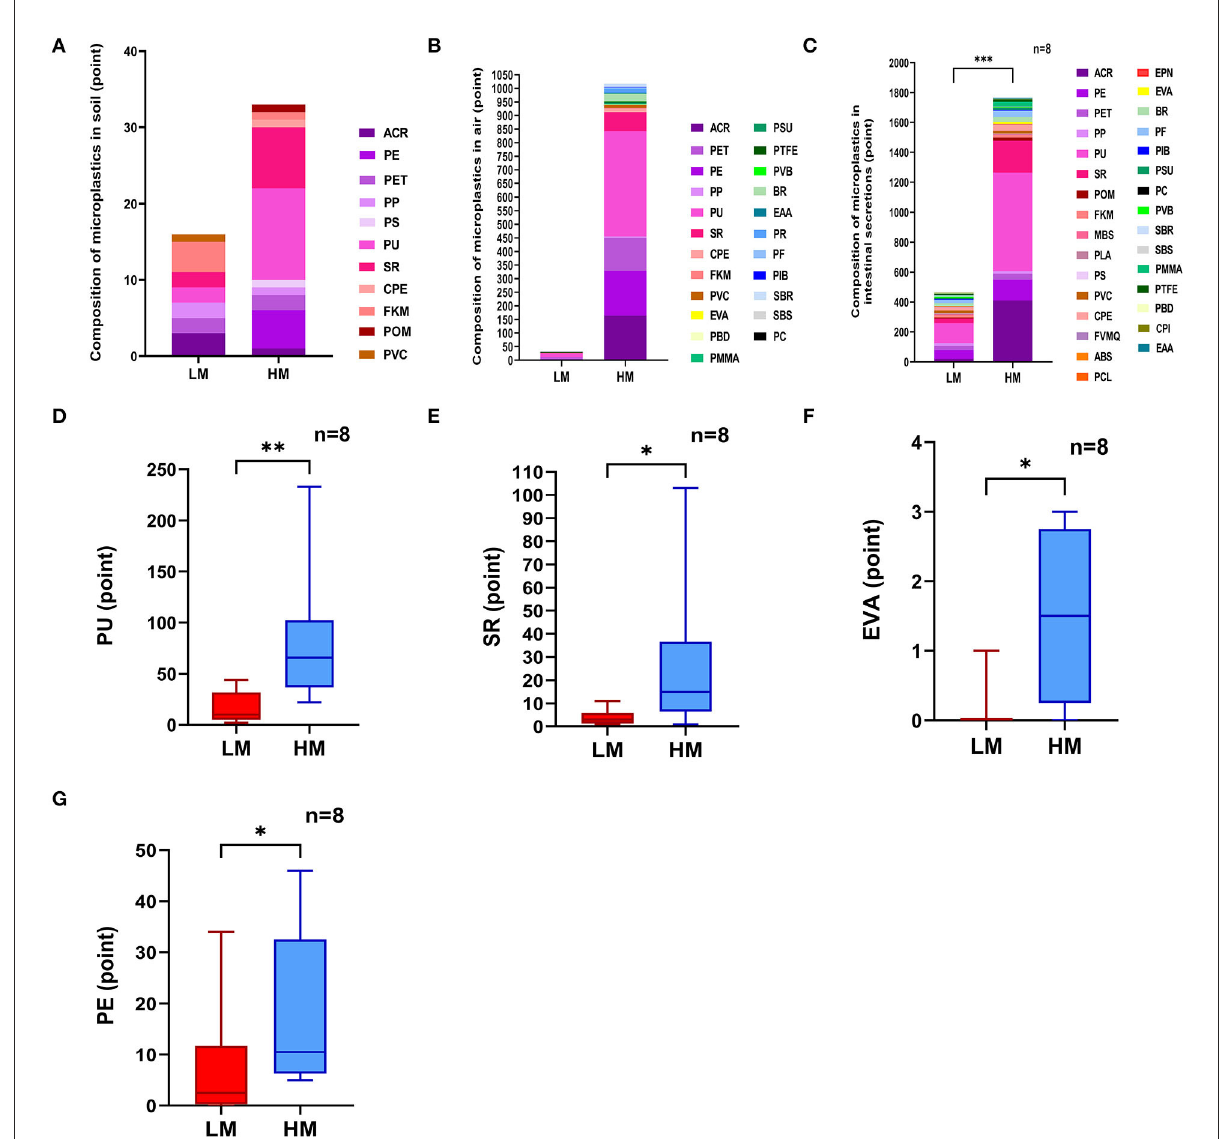
FIGURE1 Analysis of microplastics. (A) Analysis of microplastics from soil. (B) Analysis of microplastics from air particles. (C–G) Analysis of microplastics from intestinal secretions. Acrylic resin, ACR; Polyethylene, PE; Polyethylene terephthalate, PET; Polypropylene, PP; Polystyrene, PS; Polyurethane, PU; Silicon resin, SR; Chlorinated polyethylene, CPE; Fluoro rubber, FKM; Polyoxymethylene, POM; Polyvinylchloride, PVC; Ethylene-vinyl acetate, EVA; Polybutadiene, PBD; Polymethyl methacrylate, PMMA; Polysulfone, PSU; Polytetrafluoroethylene, PTFE; Polyvinyl Butyral, PVB; Butadiene rubber, BR; Ethylene-acrylic acid copolymer, EAA; Petroleum resin, PR; Phenolic resin, PF; Polyisobutylene, PIB; Properties, SBR; Styrene-butadiene-styrene copolymer, SBS; Polycarbonate, PC; Polyoxymethylene, POM; Methylmethacrylate-butadiene-styrene, MBS; Polylactic acid, PLA; Fluorosilicone rubber, FVMQ; Acrylonitrile-butadiene-styrene, ABS; Polycaprolactone, PCL; Novolac epoxy resin, EPN; Polysulfone, PSU; Polybutadiene, PBD; Chlorinated Polyisoprene, CPI; Ethylene-acrylic acid copolymer, EAA. * P < 0.05, ** P <